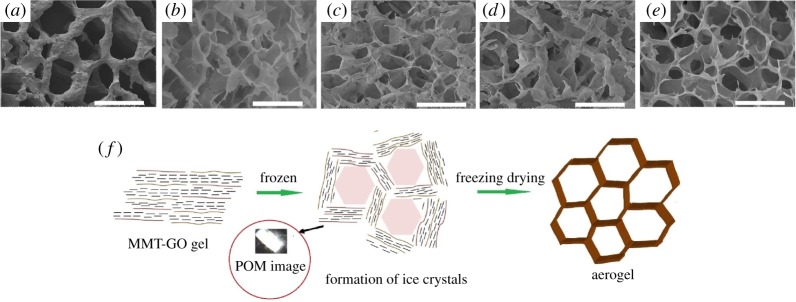
SEM image of the aerogel samples (a) MG0, (b) M40G, (c) M10G, (d) M5G, (e) M2.5G. Schematic of the formation mechanism of hexagonal shape pores through the growth of ice crystals (f).